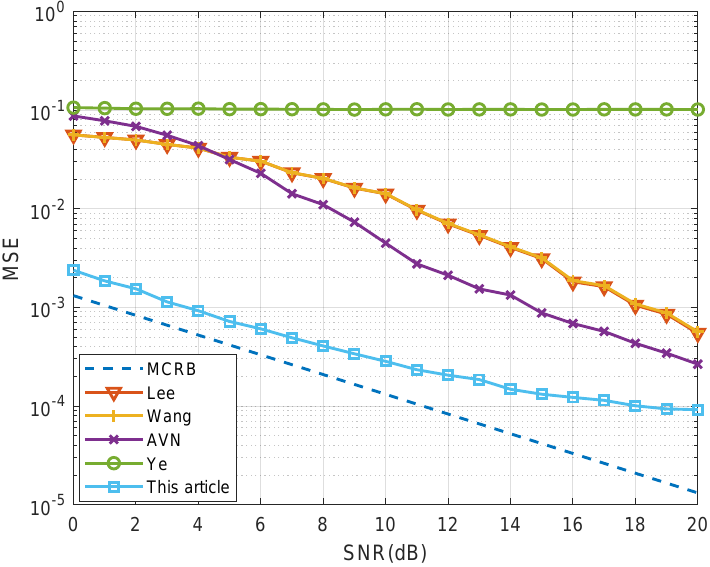
Figure 8. Timing error estimation simulation when adding 0.05 normalized frequency offset.